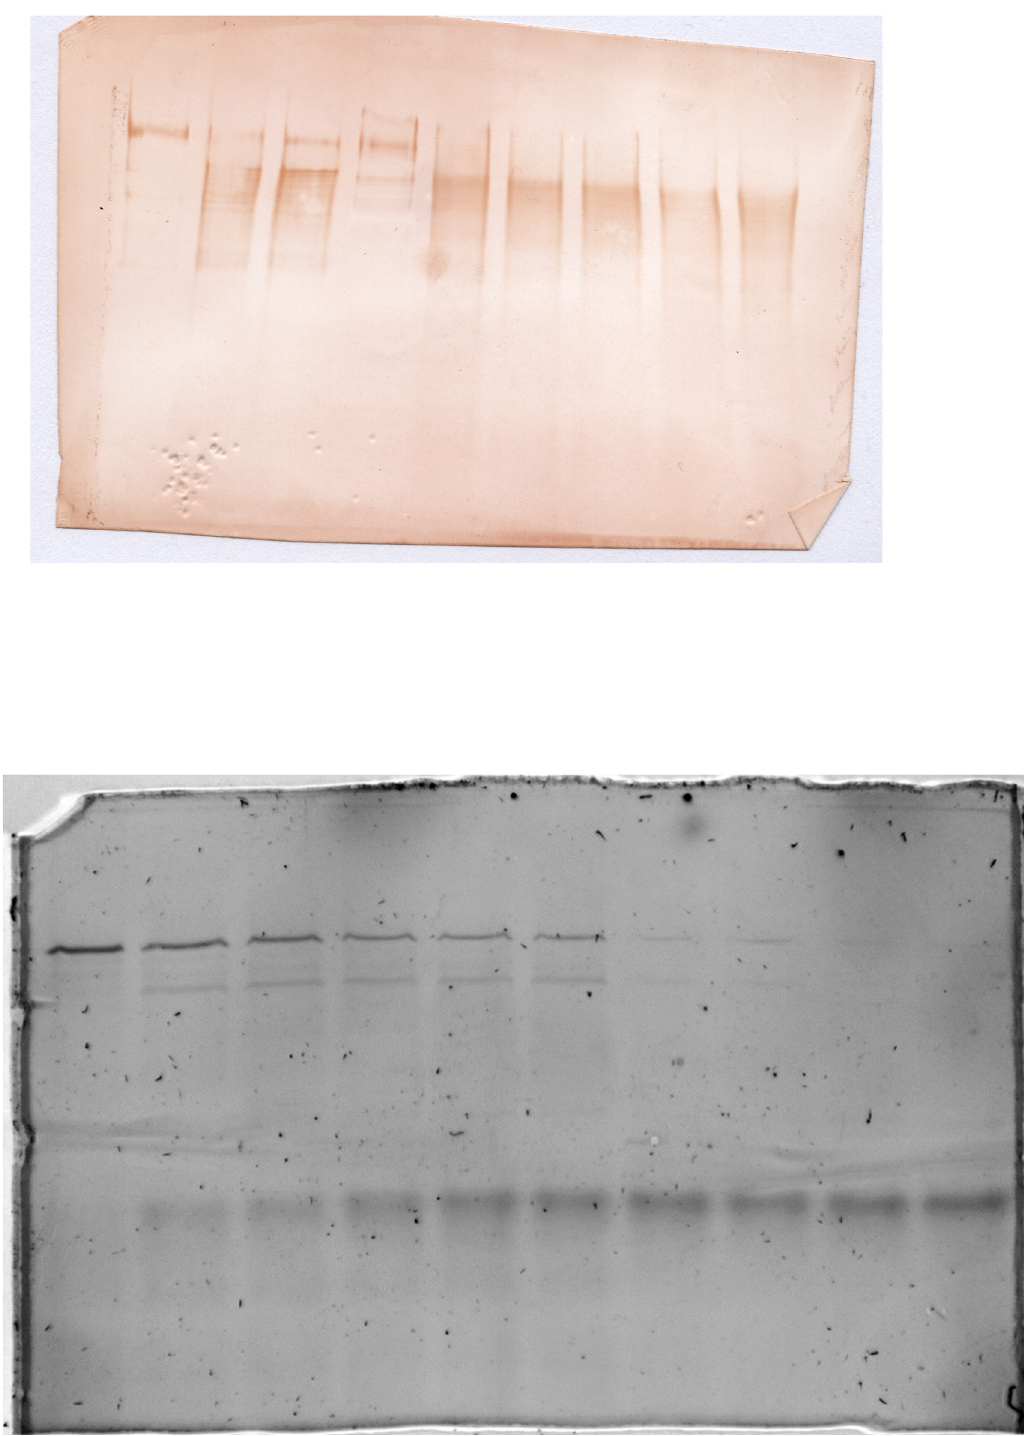
Fig 4. Chymotryptic digestion of detergent-purified Spf1p and Spf1p from yeast membranes. Top panel , 0.1 μ g of purified Spf1p in mixed detergent-lipid micelles, and 20 μ g of total S . cerevisiae membranes containing Spf1p were treated with chymotrypsin for the time indicated on top of each lane. The reaction was stopped by the addition of 4 μ g of aprotinin. The samples were run in a 9% SDS-PAGE and the Spf1p peptides detected by Western blot using an anti-Spf1p polyclonal antibody. Lower panel , 20 μ g of total S . cerevisiae membranes containing GFP-Spf1p were treated with 0.5 μ g of chymotrypsin for the time indicated on top of each lane. The samples were run in a 9% SDS-PAGE and the gel was scanned for GFP fluorescence.